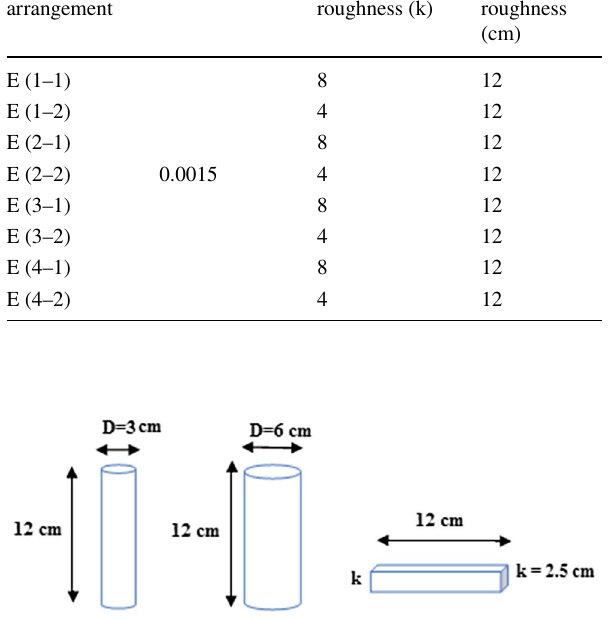
Table 1 Summary of experiments with roughed bed Roughness arrangement